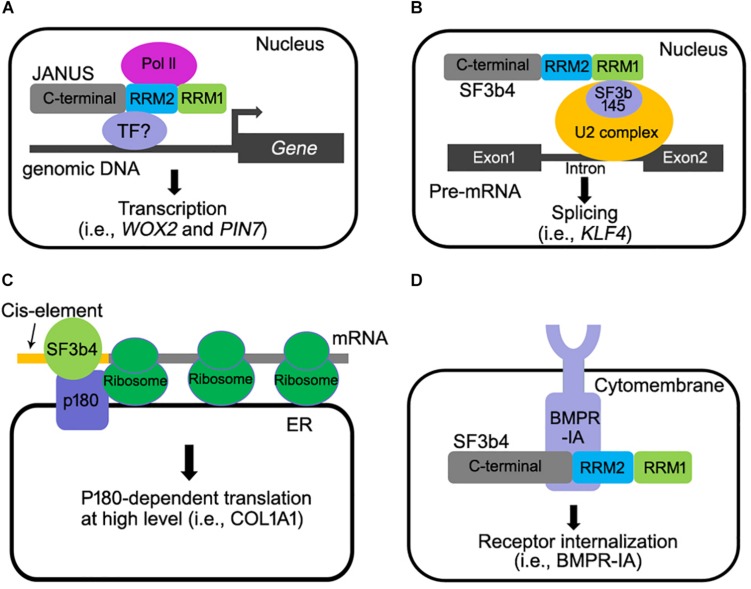
Multiple molecular functions of SF3b4 in eukaryotes. (A)
Arabidopsis JANUS directly interacts with RNA polymerase II via its RRM2 domain and regulates Pol ll-mediated transcription of specific target genes (Xiong et al., 2019). (B) SF3b4 can interact with SF3b145 via its RRM1 domain and tether the U2 snRNP to the branch site in pre-mRNA splicing (Champion-Arnaud and Reed, 1994; Igel et al., 1998; van Roon et al., 2017; Shen and Nam, 2018). (C) SF3b4 interacts with p180 at ER and mediates translational control of secretory proteins (Ueno et al., 2019). (D) SF3b4 interacts with BMPR-IA receptor kinase at cell membrane and facilitates its internalization. Both the RRM2 and C-terminal motif of SF3b4 are required for the interaction (Pignatti et al., 2014).